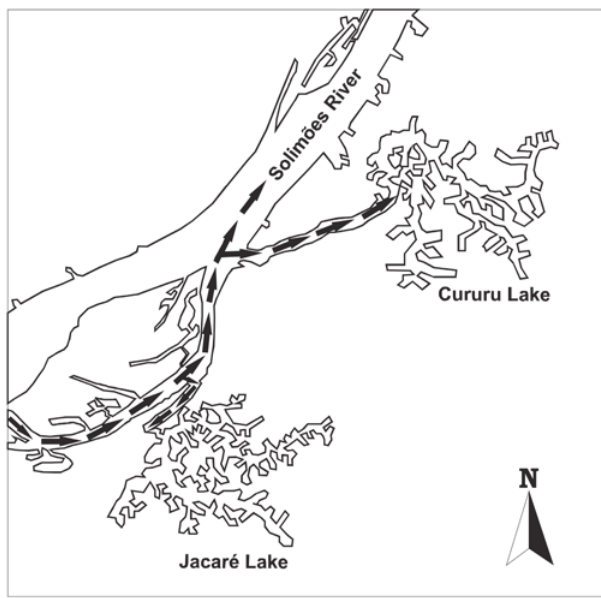
Fig. 6. Representative map showing the flow of the Solimões River in direction to the Jacaré and Cururu lake